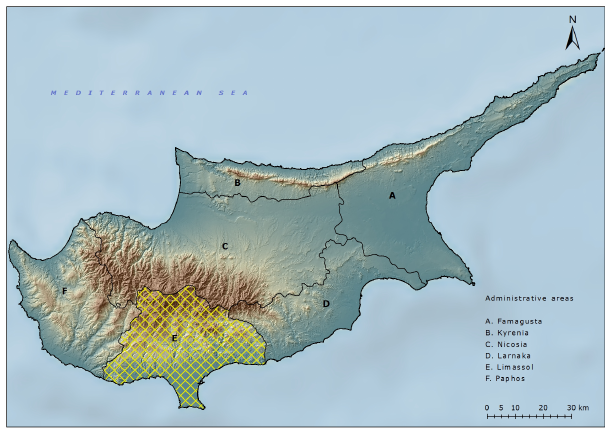
Figure 2. Study area of Limassol